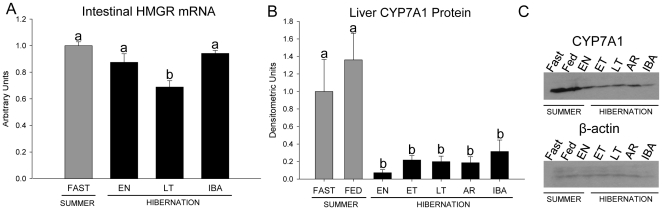
HMG-CoA reductase (HMGR) intestinal mRNA expression and Cholesterol 7 alpha-hydroxylase (CYP7A1) liver protein expression.Gene and protein expression in fasted summer (SUM) (grey bars) squirrels and hibernators (filled bars) in entrance (EN), early torpor (ET), late torpor (LT), arousal (AR), and interbout arousal (IBA) are shown. HMGR gene expression is normalized to reference genes (acidic ribosomal phosphoprotein, succinate dehydrogenase complex subunit A, and hypoxanthine-guanine phosphoribosyltransferase) and expressed relative to SUM which was set at 1.0. CYP7A1 expression is normalized to β-actin protein expression (example blot panel C). Groups with the same letter are not different. All values represent means ± s.e.m. and n = 5 or 6.